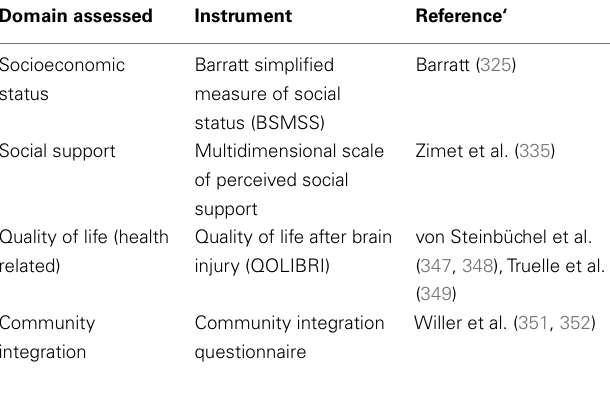
Table 13 | Instruments recommended for sociological